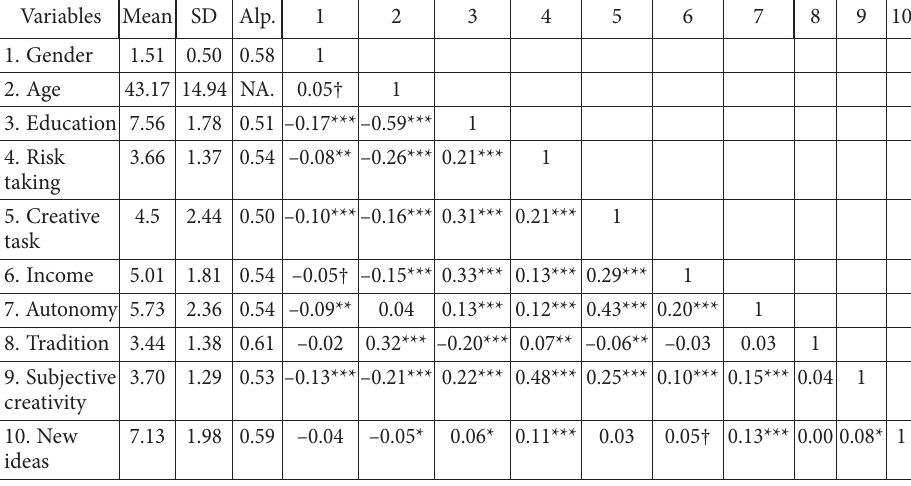
Table 2. Descriptive statistics and correlation among variables (source: created by authors) Variables Mean SD